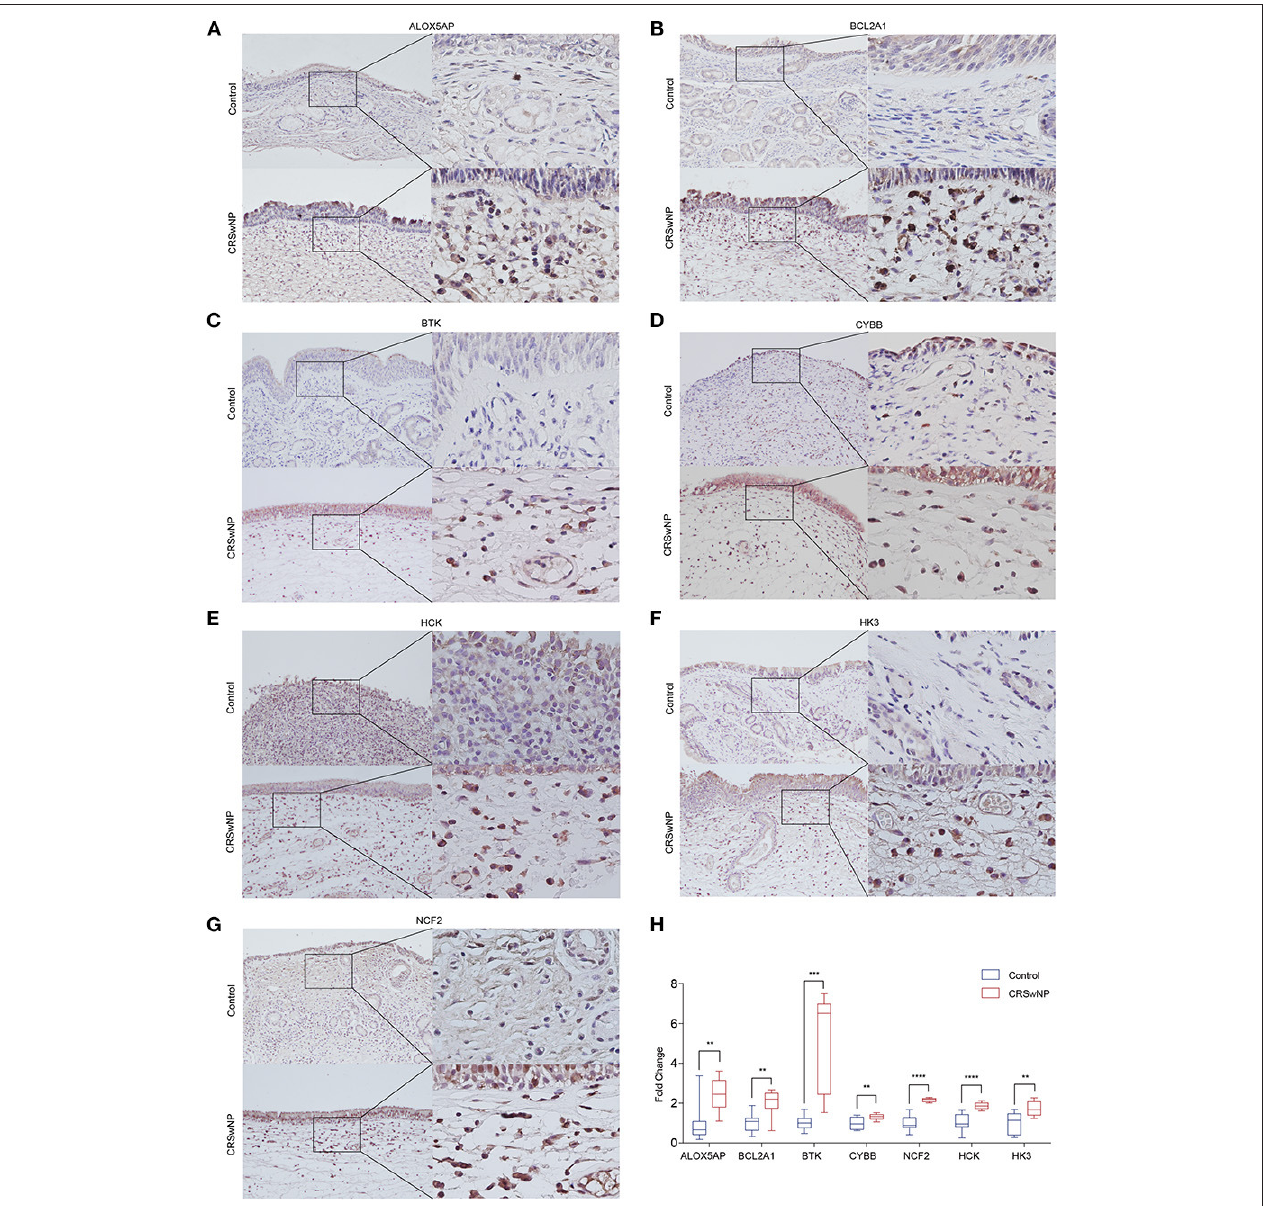
FIGURE 6 | The protein expression levels 7 hub genes were significantly increased in CRSwNP by immunohistochemistry staining. (A–G) The expression level and location distribution of ALOX5AP, BCL2A1, BTK, CYBB, NCF2, HCK, and HK3 proteins in nasal polyps from CRSwNP patients ( n = 11) and nasal mucosal tissues from healthy control ( n = 7). (H), Fold changes of average optical density value in the ALOX5AP, BCL2A1, BTK, CYBB, NCF2, HCK, and HK3 protein expression in CRSwNP and healthy controls. ** P < 0.01, *** P < 0.001, **** P <